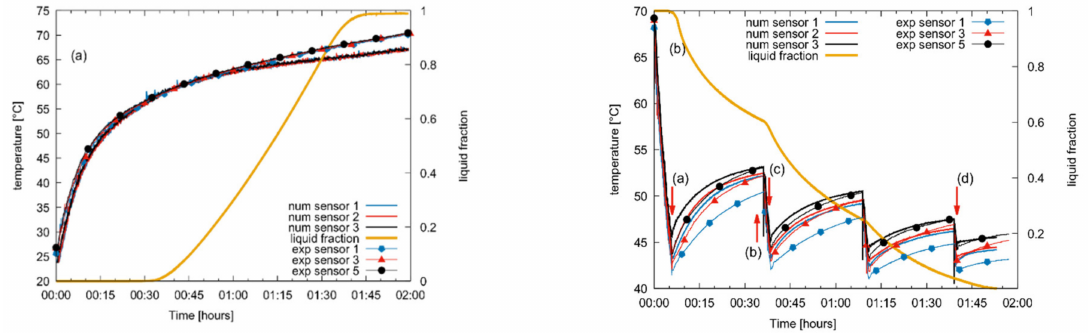
Figure 13. Results obtained with the Fluent mode and comparison with experimental results, temper- ature at sensors and liquid fraction for. ( a ) Test 1 charge phase, ( b ) Test 2 discharge